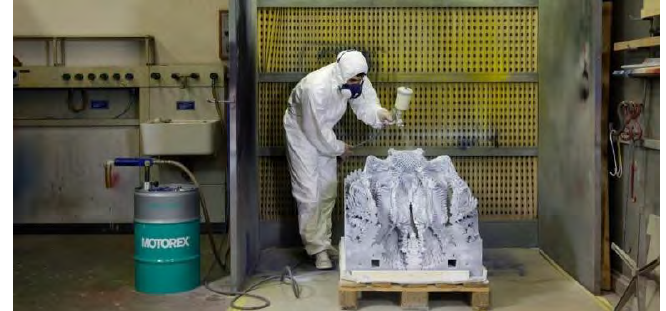
Figure 12. Thefinishing coat.